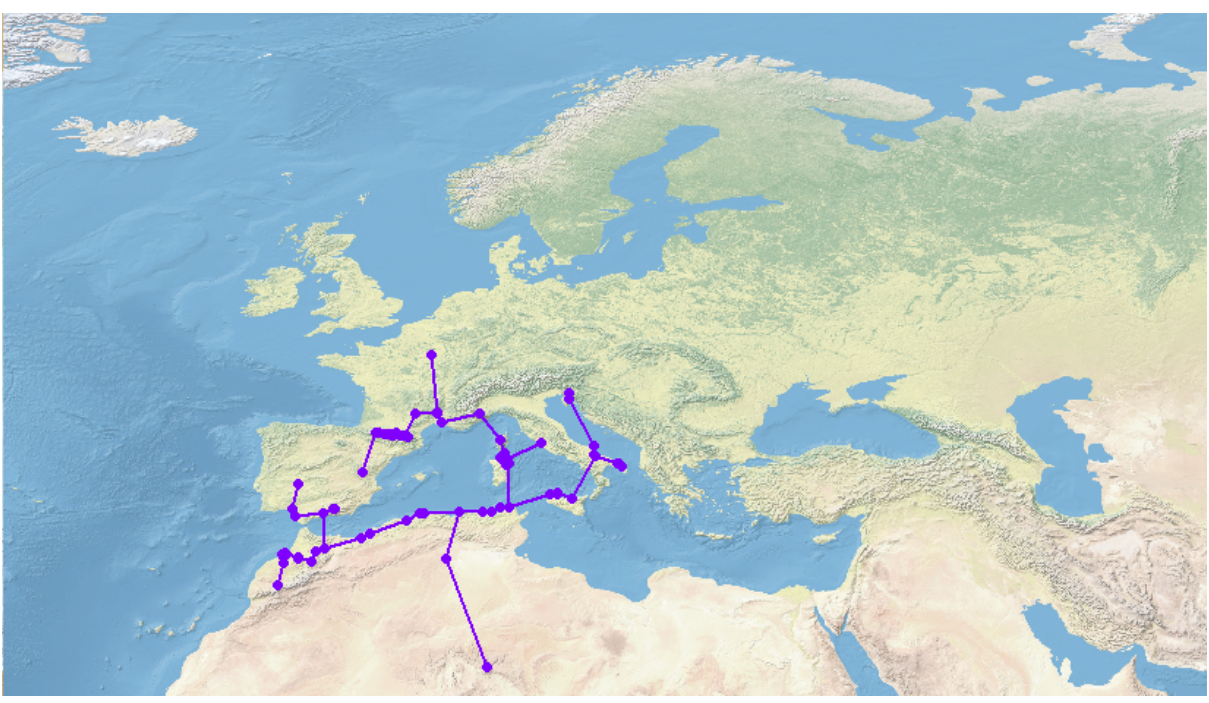
Figure 4. Individual track of Diaptomus cyaneus